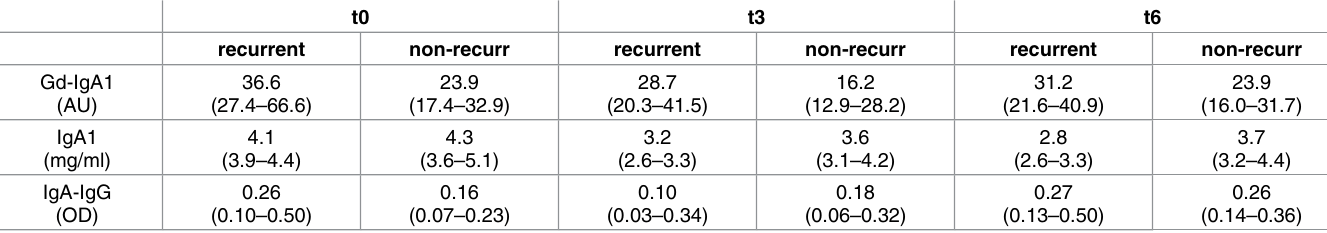
Table 3. Gd-IgA1, total IgA1 and IgA-IgG complexes in recurrentand non-recurrent patients at t0, t3 and t6. t0 t3